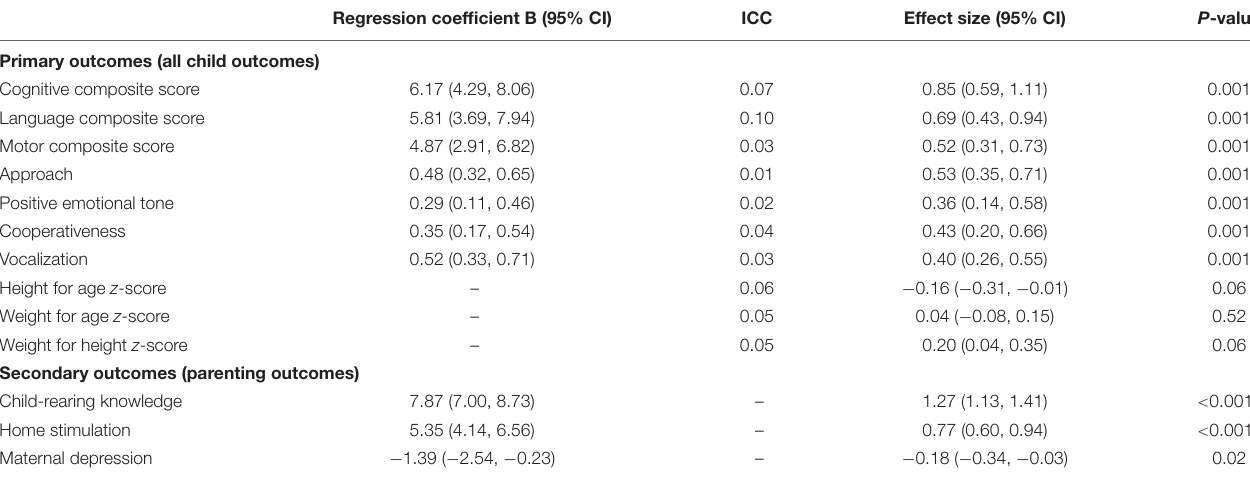
TABLE 2 | Effect of intervention on primary and secondary outcomes at